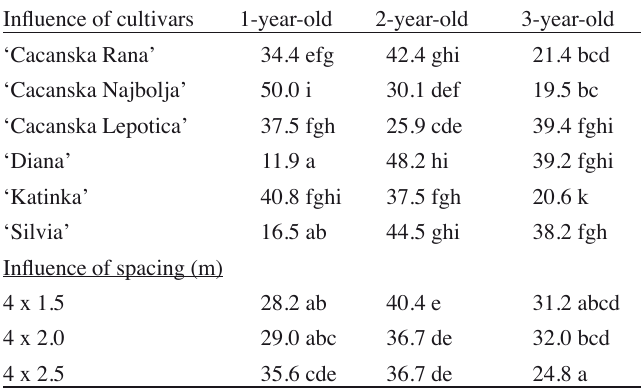
Different letters indicate significant differences separately for cultivars and spacing at P=0.05.